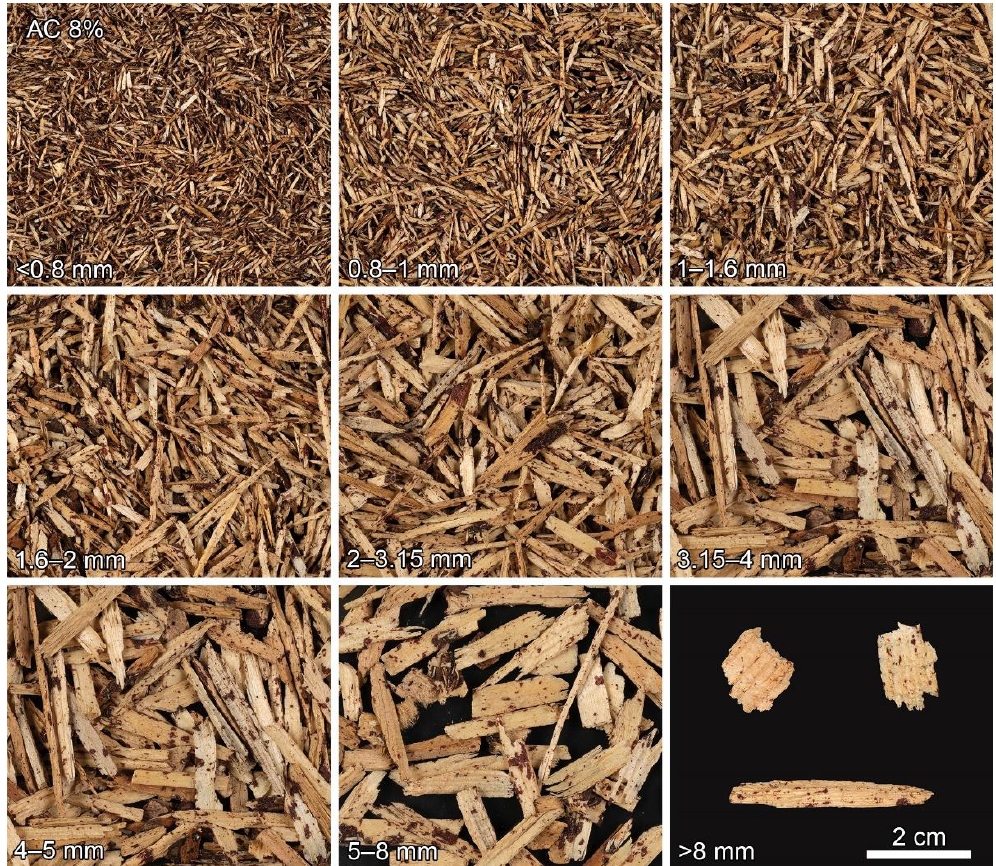
Figure 2. Sieve-fractionated Particle Material 2 (AC